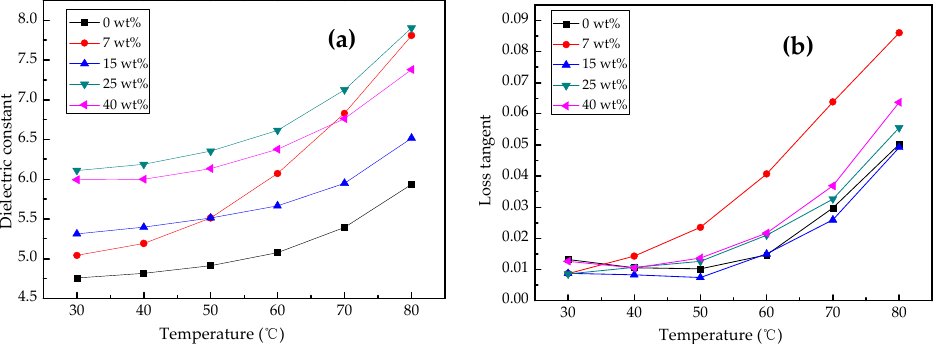
Figure 9. The temperature-dependent dielectric constant ( a ) and the dielectric loss tangent ( b ) of the pure epoxy resin ( ■ ) and the 7 ( ● ), 15 ( ▲ ), 25 ( ▼ ), and 40 wt % ( ◀ ) composites at 1 kHz at room temperature.